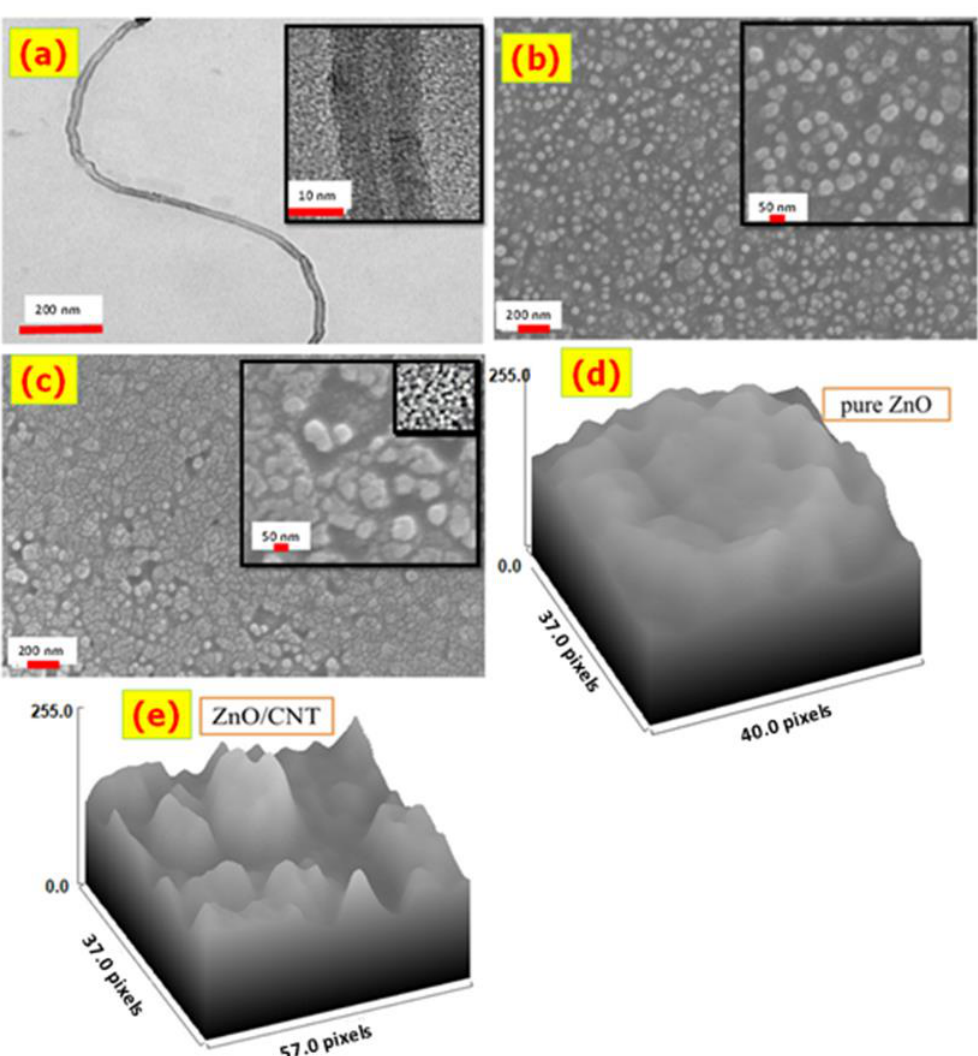
Figure 2. ( a ) HRTEM image of the CNTs. The HRSEM image of the ( b ) ZnO and ( c ) ZnO/CNTs thin films, and ( d ) surface roughness of ZnO and ( e ) surface roughness of